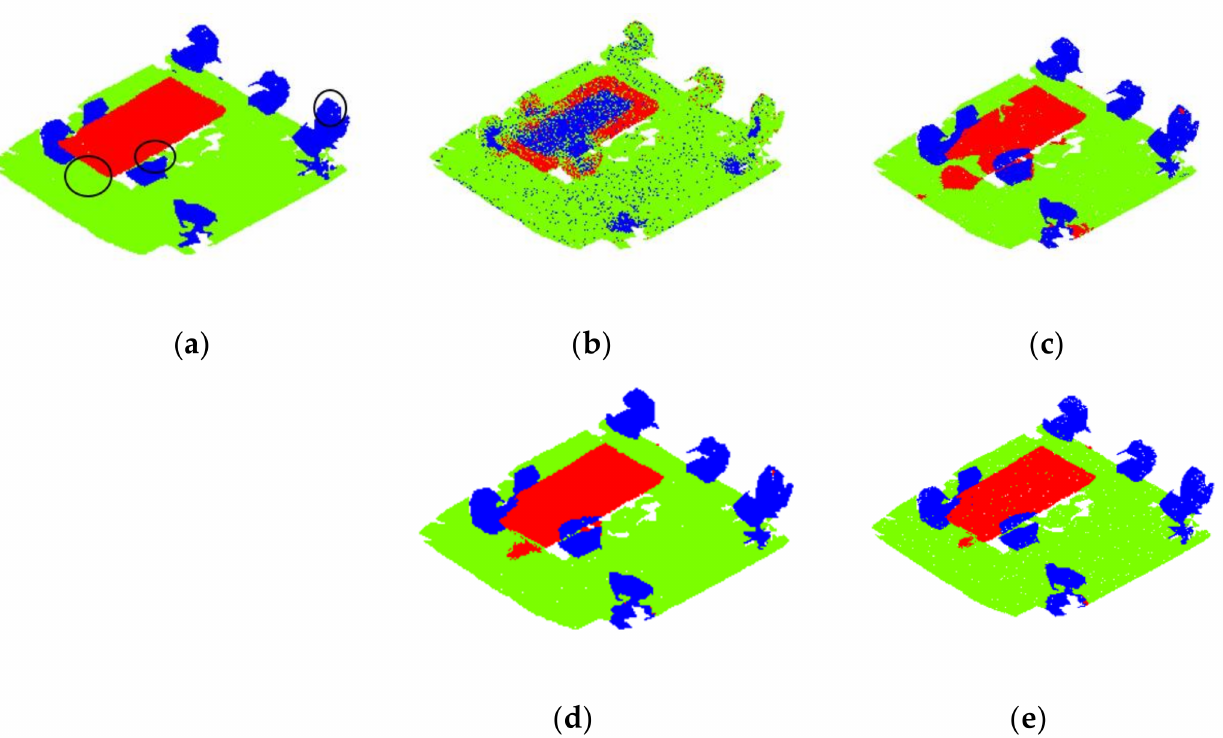
Figure 12. Classification results for Scene 4. ( a ) Ground truth; ( b ) Method 1; ( c ) Method 2; ( d ) Method 3; and ( e ) our method. Red, green, and blue points represent the table, floor, and chair, respectively.